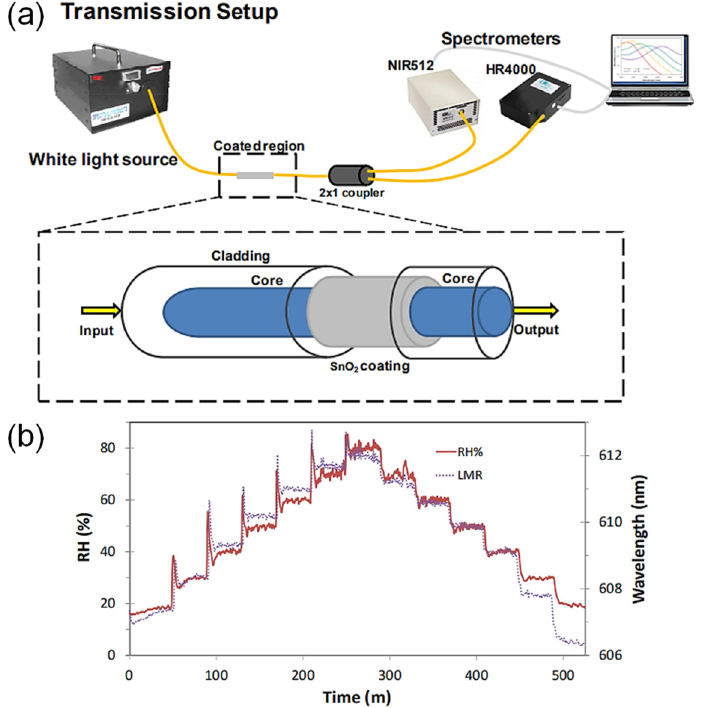
Figure 20. Point sensor. ( a ) Experimental setup and sensor head design. ( b ) Spectral response. Reprinted with permission from [93] © SPIE . Adapted with permission from ref. [93]. Copyright 2013 SPIE